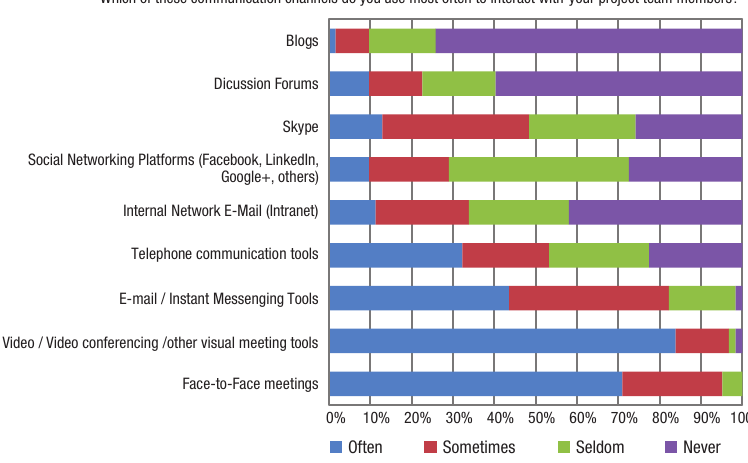
Fig. 6. Communication modes in project